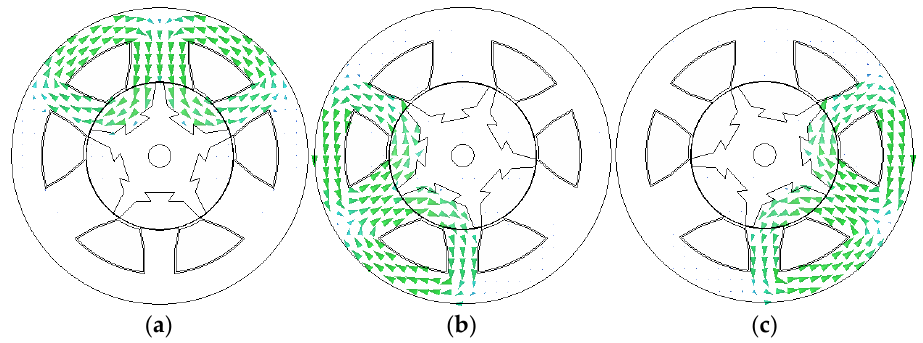
Figure 4. Magnetic field vector of proposed 6/5 SRM. ( a ) Phase A windings excited only; ( b ) Phase B windings excited only; ( c ) Phase C windings excited only.